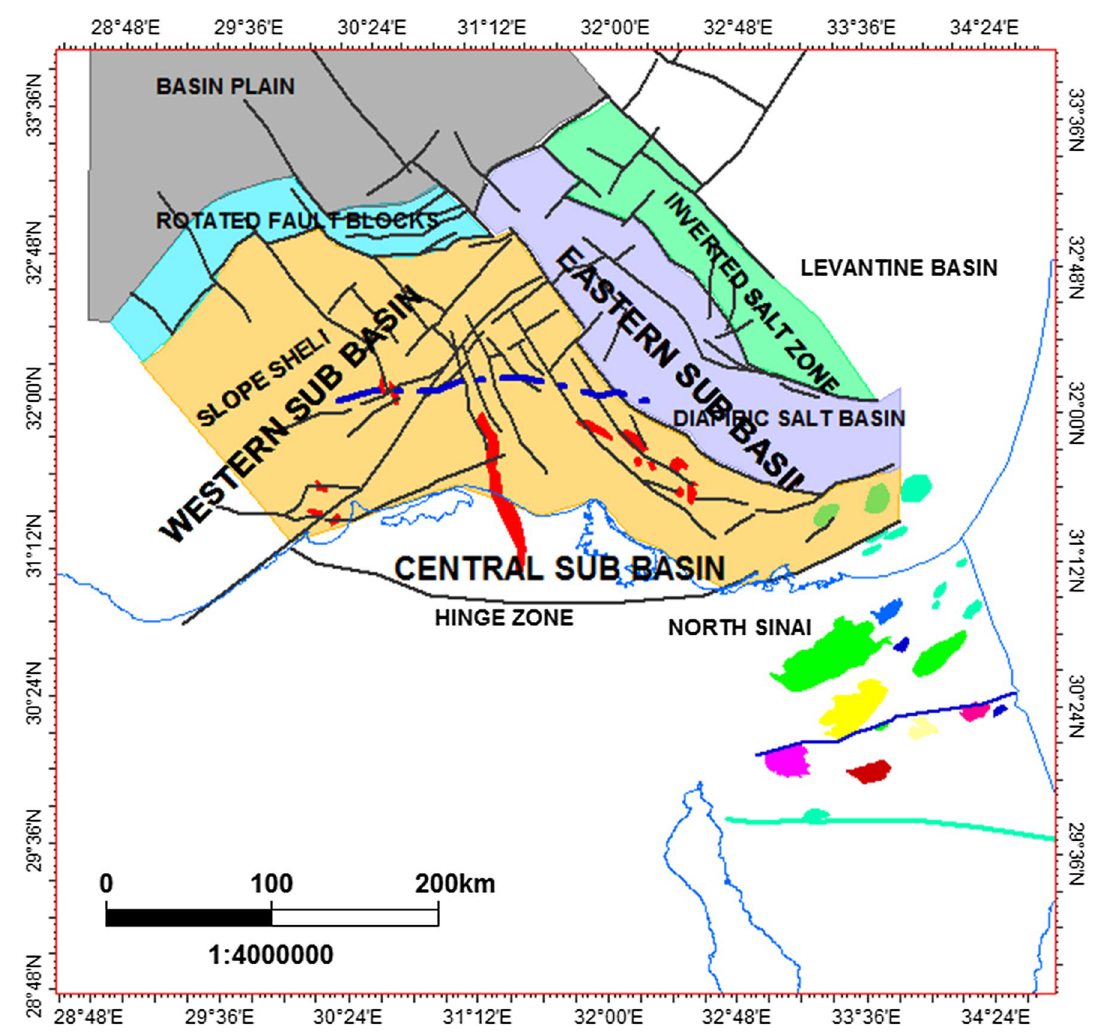
Fig. 2 Major structural elements of Nile Delta, the black solid lines are the main faults, associated with salt-related features (El Barkoky and Helal 2002) and North Sinai structure (El Heiny and Enani 1996) in the Nile Delta as shown in the figure. The colored spots are the